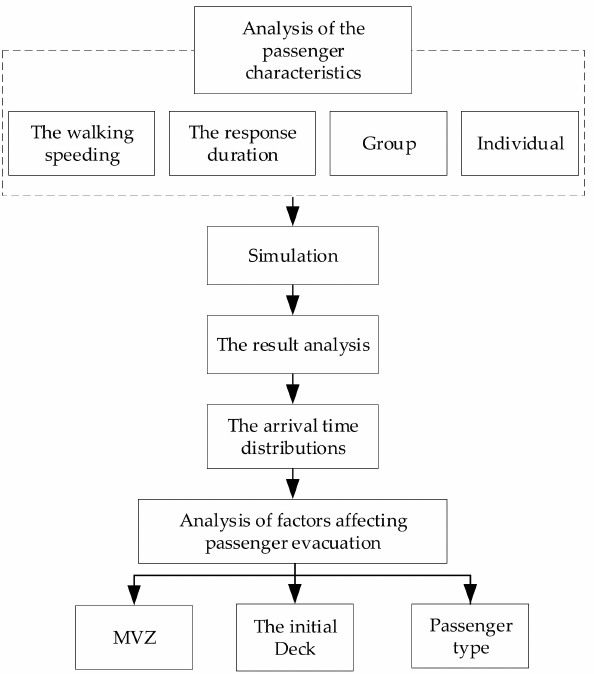
Figure 5. The description of the